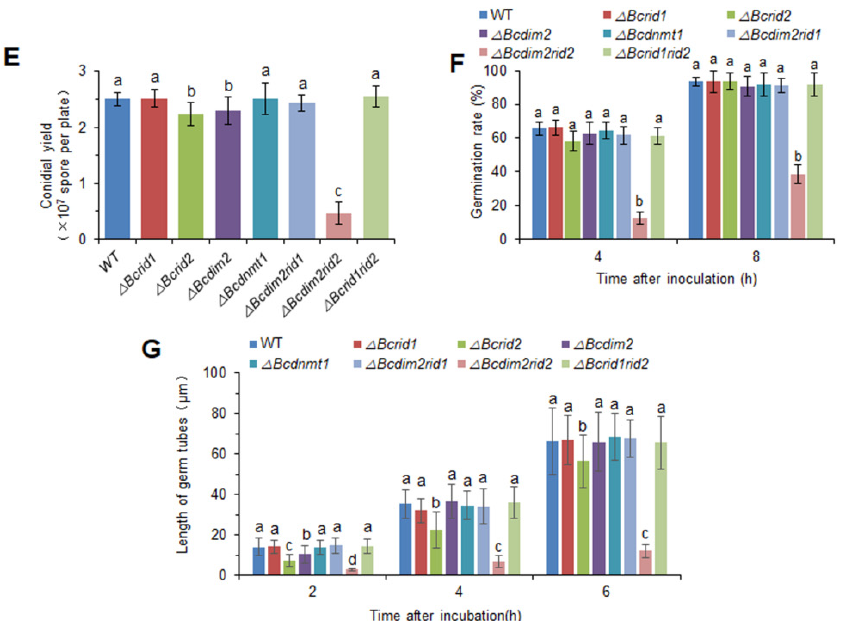
Figure 5. DNA MTases affect the vegetative growth and conidiation of B. cinerea . ( A ) Colony morphology of wild-type and mutants after culturing for 4 d on PDA plates. ( B ) Statistical analysis of radial growth of wild-type and mutants. ( C ) Mycelial morphology of wild-type and mutants. ( D ) Conidial morphology of wild-type and mutants. ( E ) Conidial yield of wild-type and mutants after culturing for 14 d. ( F ) Statistical analysis of the germination rates of wild-type and mutants. Vertical bars represent standard errors of the means. ( G ) The tube length of different mutants at 2 h, 4 h, and 6 h after inoculation. Columns with different letters indicate significant differences ( p < 0.05).